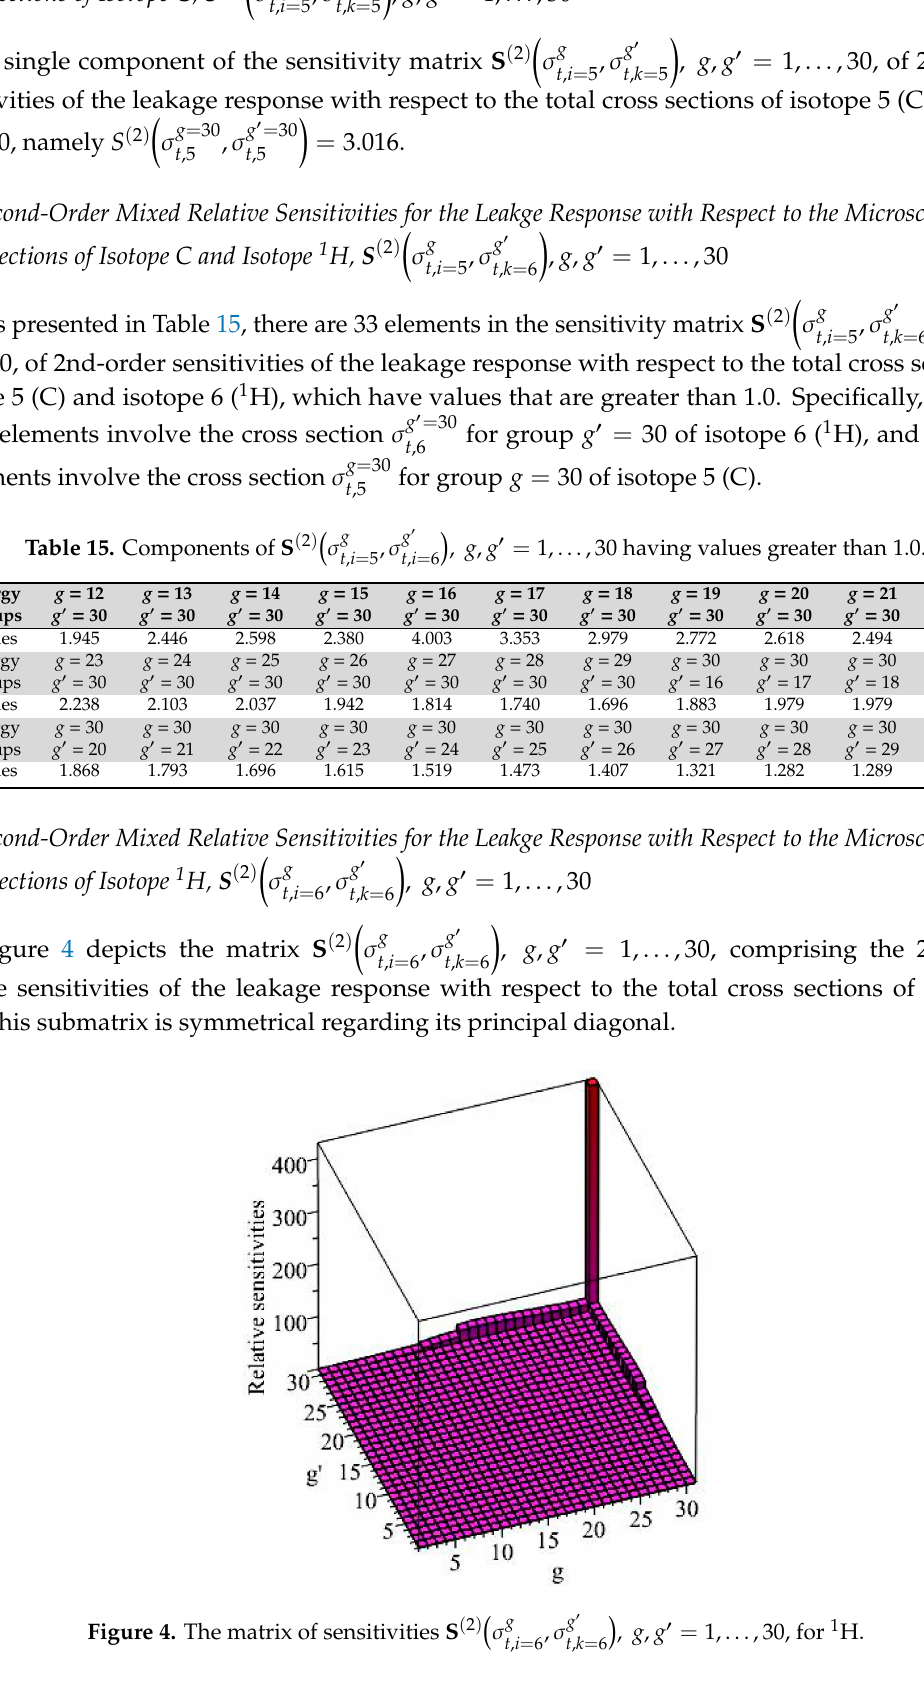
Figure 4. The matrix of sensitivities S ( 2 )